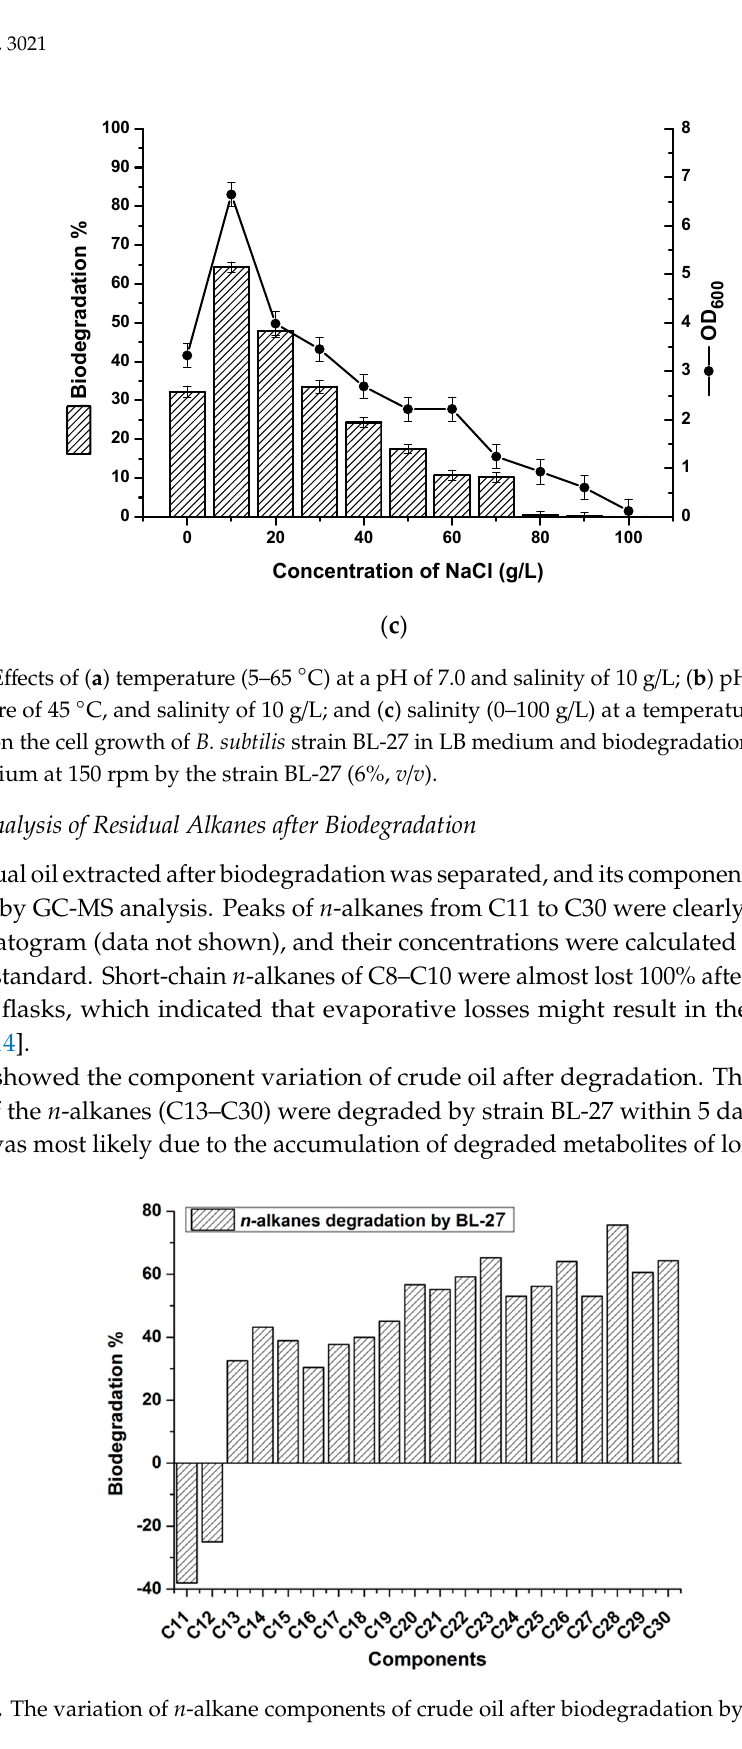
Figure 3. The variation of n -alkane components of crude oil after biodegradation by strain BL-27.